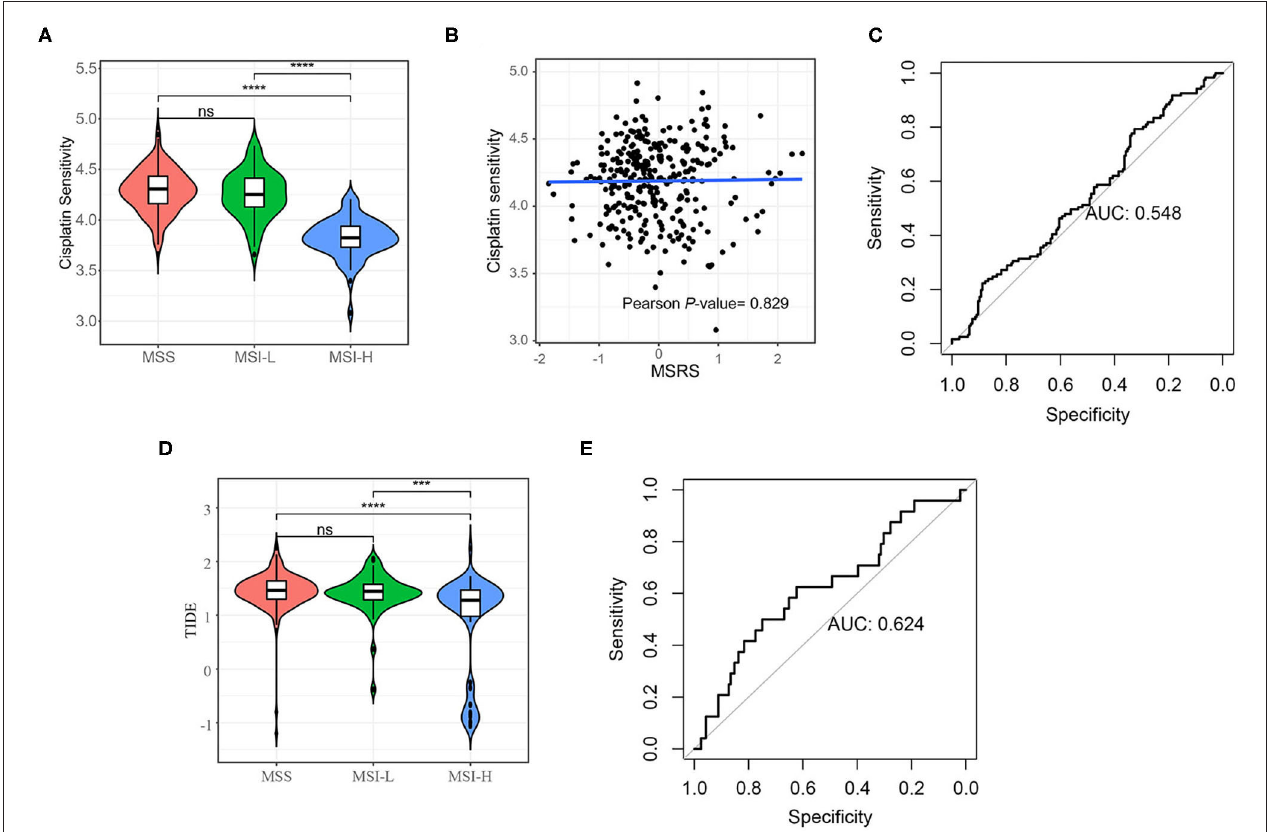
FIGURE 8 | Cisplatin sensitivity and immunotherapy sensitivity analysis. (A) Violin plot shows that the MSI-H colon cancers are less sensitivity to cisplatin (A) and more sensitivity to immunotherapy (D) ; (B) Scatter plots and the fitting curve show the correlation between cisplatin and the MSRS; (C) the ROC curve shows the discrimination ability of the MSRS on cisplatin response (C) and immunotherapy response (E) . The Mann–Whitney U-test ; ns: p > 0.05; * P < 0.05; ** P < 0.01; *** P < 0.001; **** P < 0.0001. AUC: area under the